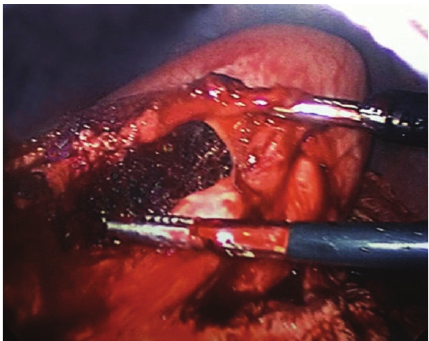
Figure 5: Piecemeal extraction of the bezoars from gastrotomy